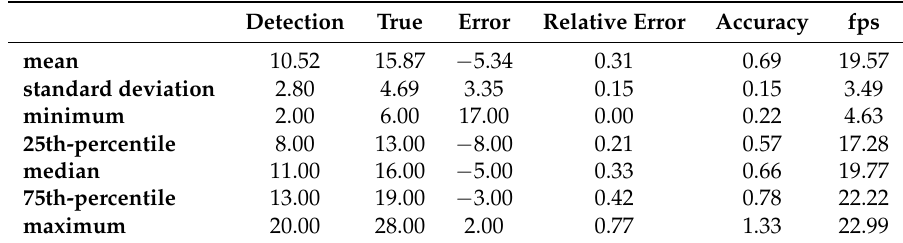
Table 3. Summary of the performance results with basic statistics computed over the 4500 frames.